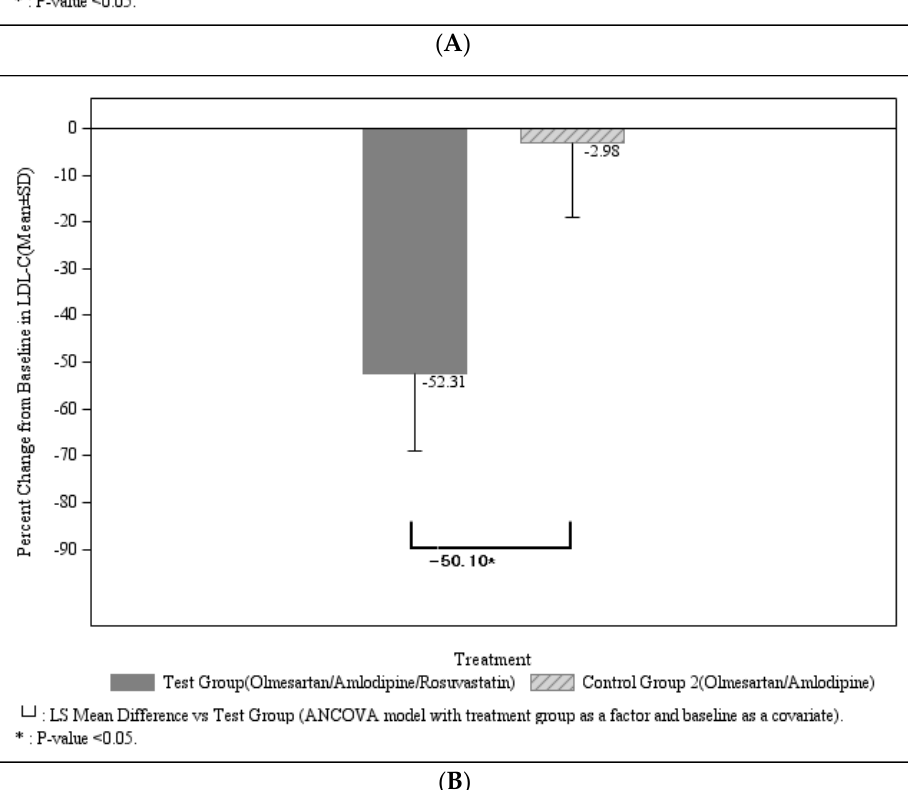
Figure 3. ( A ) Change of sitSBP in olme/amlo/rosu vs. olme/rosu after 8 week treatment ( B ) Change of LDL-C in olme/amlo/rosu vs. olme/amlo after 8 week treatment. The sitSBP change from baseline between olme/amlo/rosu vs. olme/amlo were − 24.30 ± 12.62 mmHg and − 22.89 ± 11.74 mmHg, respectively, with no difference (LS mean di ff erence (SE), − 0.63 ± 2.02 mmHg, p = 0.7555) despite that intra-group BP reduction in each group was significant (both p < 0.0001). The LDL-C change in olme/amlo/rosu was − 52.31 ± 16.63% and − 51.38 ± 17.46% in olme/rosu group at 8-week with statistic significance in each intra-group, but inter-group difference of change between 2 groups was − 1.34 ± 2.33% with no di ff erence ( p = 0.5667). The change of sitDBP in olme/amlo/rosu vs. olme/rosu vs. olme/amlo at 4- and 8- week were − 11.83 ± 7.52 mmHg, − 4.23 ± 8.52 mmHg, − 10.21 ± 7.50 mmHg and − 12.06 ± 7.81 mmHg, − 4.72 ± 9.01 mmHg, − 12.46 ± 7.01 mmHg, respectively, with statistical significance in each group (all p < 0.0001 as compared to baseline in each group at 4 and 8 weeks). The change of sitDBP in olme/amlo/rosu at 4 and 8 weeks was significantly greater as compared to that of olme/rosu with group di ff erence of − 8.53 ± 1.07 mmHg (LS mean difference (SE), p < 0.0001) at 4 weeks and − 8.33 ± 1.11mmHg (LS mean difference [SE], p < 0.0001) at 8 weeks, but the difference of sitDBP change from baseline at 4 and 8 weeks between olme/amlo/rosu vs. olme/amlo were not different with LS mean difference (SE), − 1.51 ± 1.12 mmHg, ( p = 0.1806) and 0.57 ± 1.14 mmHg, ( p = 0.6160), respectively. The rate of target BP attainment at 8 weeks, defined as sitSBP < 140 and/or sitDBP < 90 mmHg (for those with ≥ 60 years, sitSBP < 150 and/or sitDBP < 90 mmHg) was 84.76% (89/105) in olme/amlo/rosu group, 47.06% (48/102) in olme/rosu, and 76.92% (40/52) in olme/amlo group. This rate was significantly higher in the olme/amlo/rosu group as compared to the olme/rosu group ( p < 0.0001) but did not differ between olme/amlo/rosu vs. olme/amlo group. ( p = 0.2272) The rate of target LDL-C attainment according to the risk category of the NCEP ATP III guideline (for example, if risk factor 0–1, responder had LDL-C < 160 mg/dL, if risk factor ≥ 2 and 10 year risk ≤ 20%, responder had LDL-C < 130 mg/dL, and if coronary heart disease (CHD) or CHD risk equivalents or 10 year risk > 20%, responder had LDL-C < 100